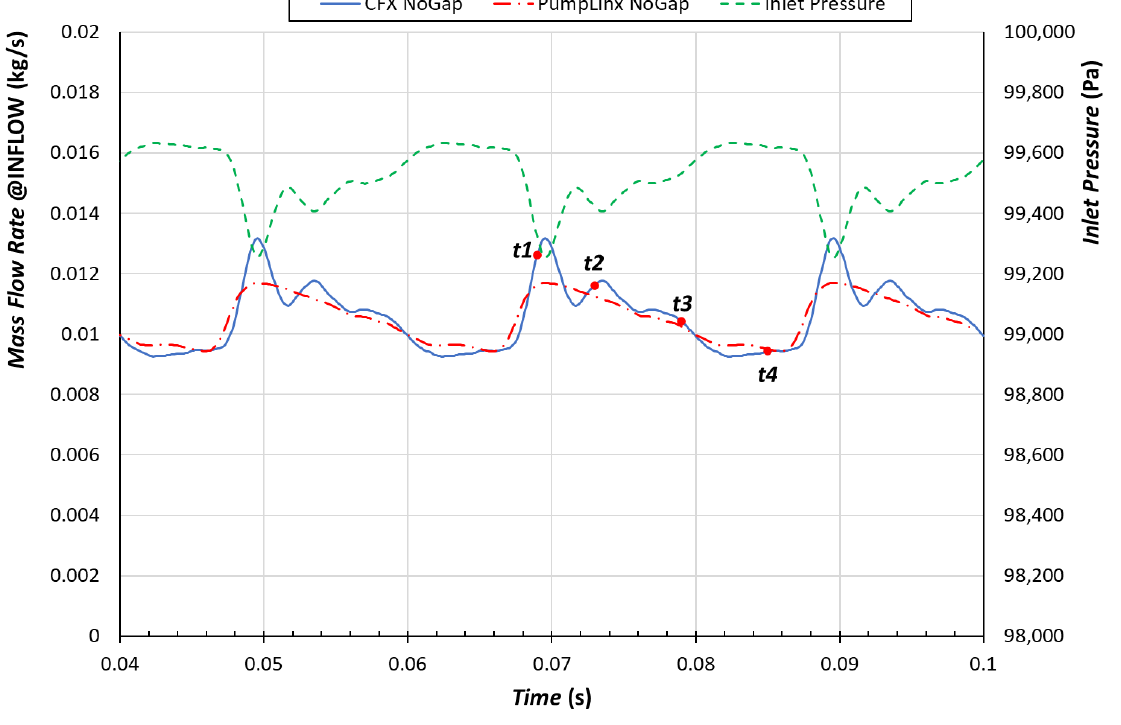
Figure 9. Evolution over time of the mass flow rate at the inlet port, and pressure at the inlet port during the last three orbit revolutions of the rotating scroll: CFX inlet mass flow (solid line), PumpLinx inlet mass flow (dash-dot line), and CFX inlet pressure (dotted line).